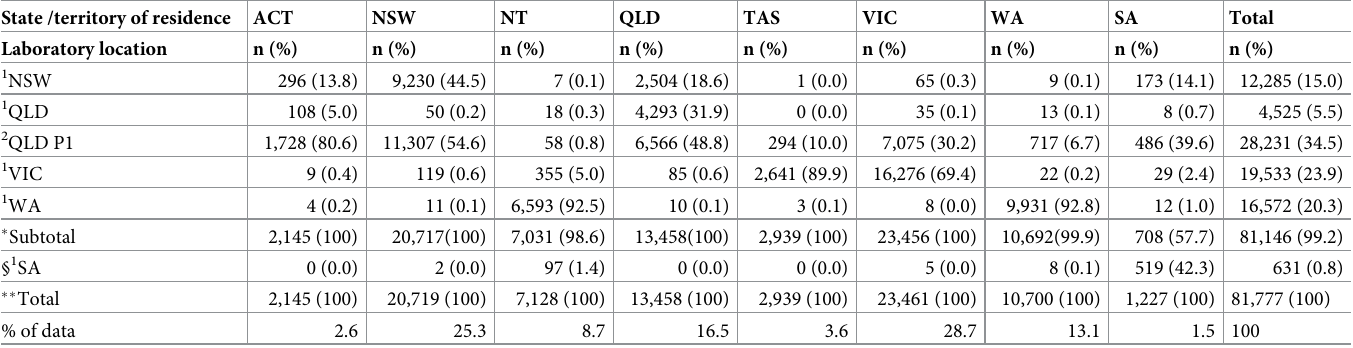
Table 1. Contribution of each laboratory to the Strongyloides serology data, 2012–2016, number of people tested and percentage of the data contributed by each lab- oratory to each state or territory of